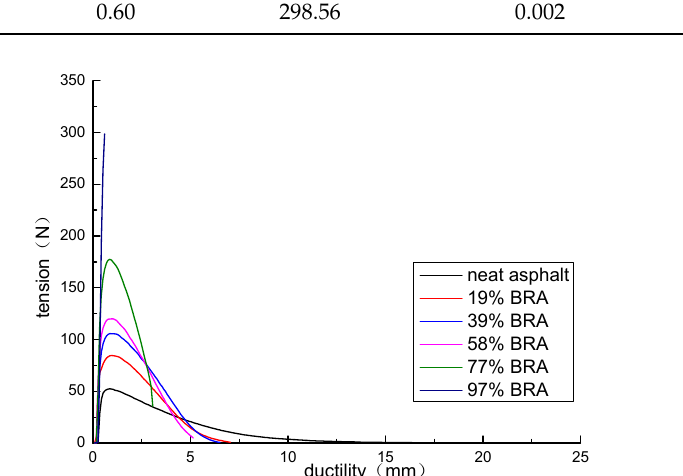
Table 12. Force ductility test result of BRA ash asphalt mortar.